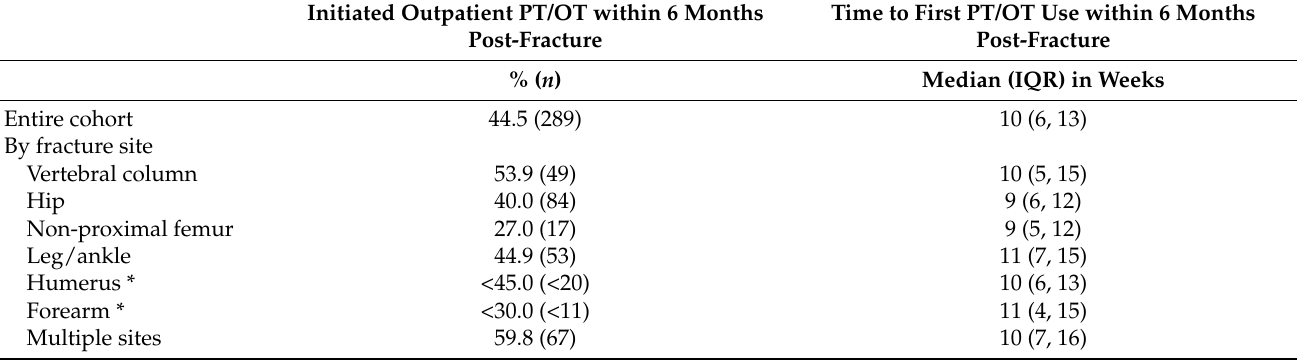
Table 3. Proportion of and median time to first outpatient physical or occupational therapy (PT/OT) service within 6 months post-fracture for the entire cohort ( n = 649) and then by fracture site.